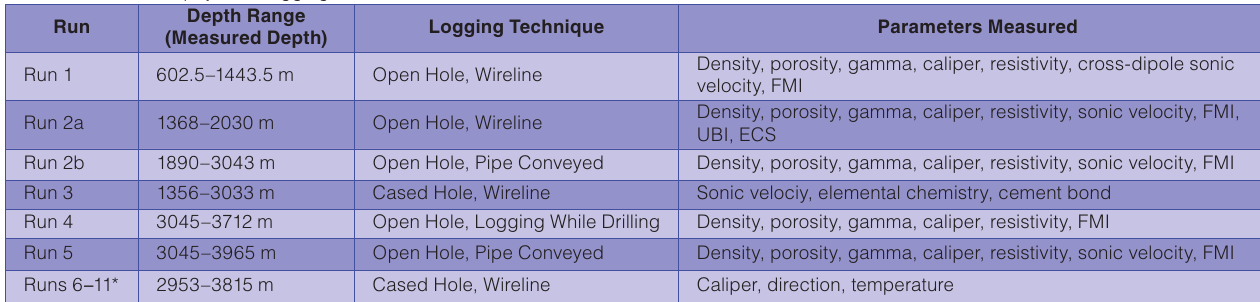
Table 3. SAFOD Geophysical Logging